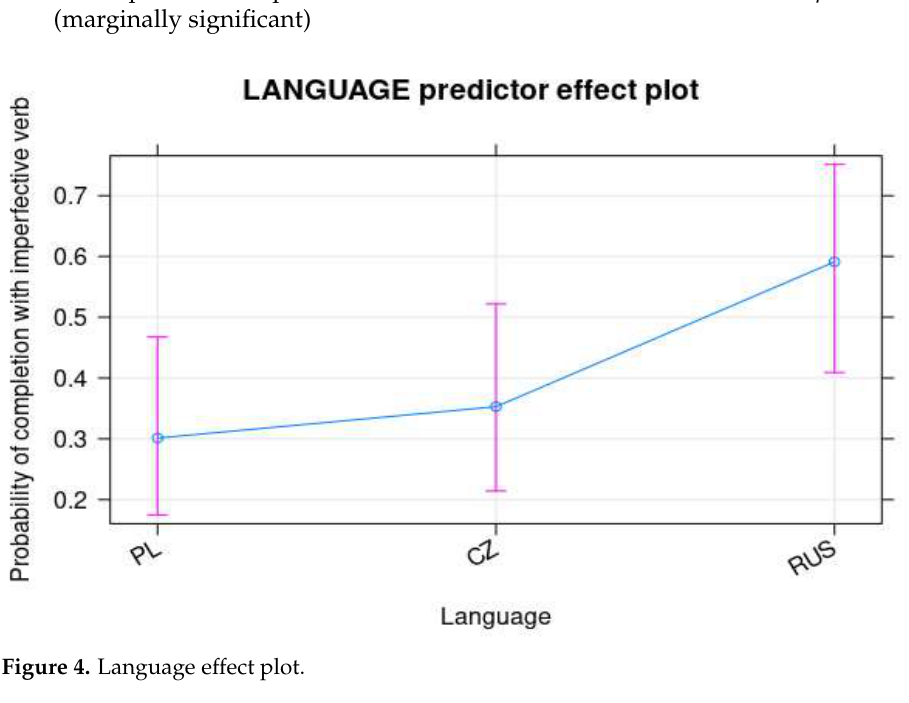
Figure 4. Language effect plot.